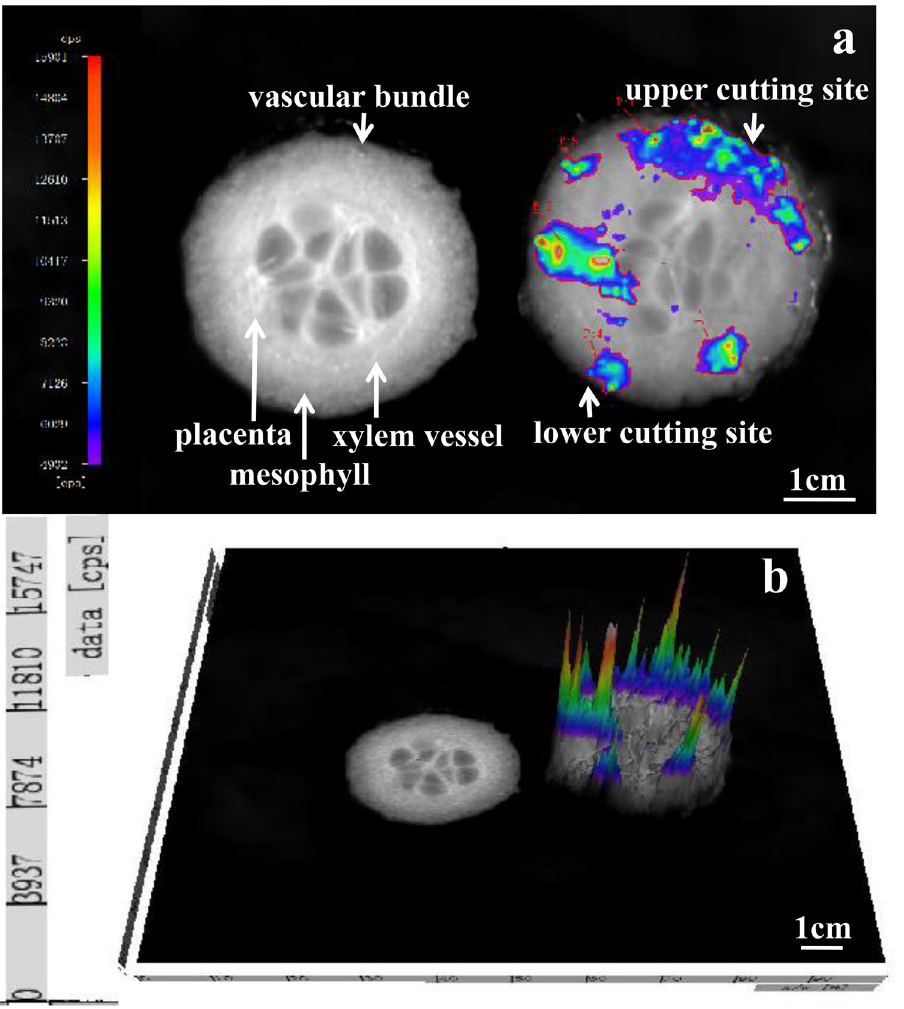
Figure 1. Immediate BL images of E. coli transfered and distributed on the cross-section of cucumber. ( a ) The left side was the control of uncontaminated cucumber slices, the right side was the cucumber slice after cutting horizontally by a knife inoculated with E. coli (7.06 ± 0.25 log CFU/mL). ( b ) 3D surface chart of the same processed sample. The red color represented a strong signal and the blue color represented a weak signal. IndiGo software (https:// www. nchso ftware. com/ accou nting/ index. html? kw= sage% 20soft ware & gclid= AIaIQ obChM I3MvFj- zr7wI Vj2gq Ch14f AmLEA EYASA AEgJP qPD_ BwE, https:// softw areto pic. infor mer.